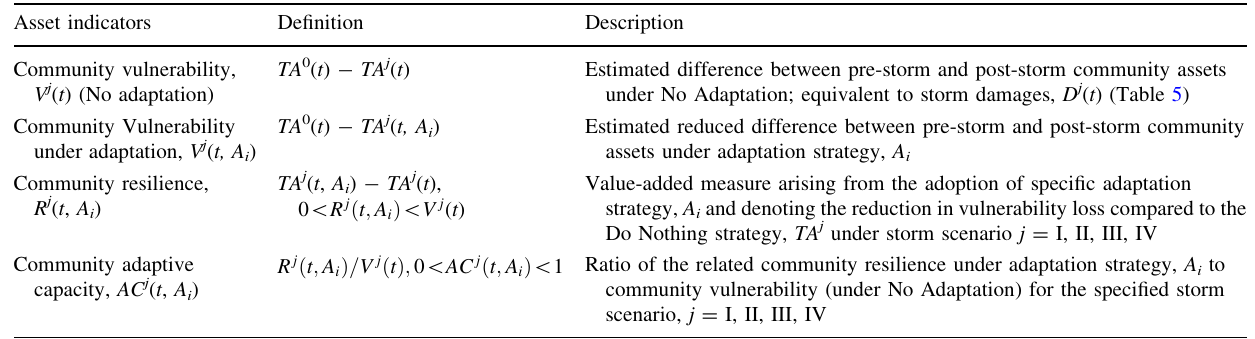
Table 8 System dynamics model asset-based indicators: vulnerability, resilience, and adaptive capacity Asset